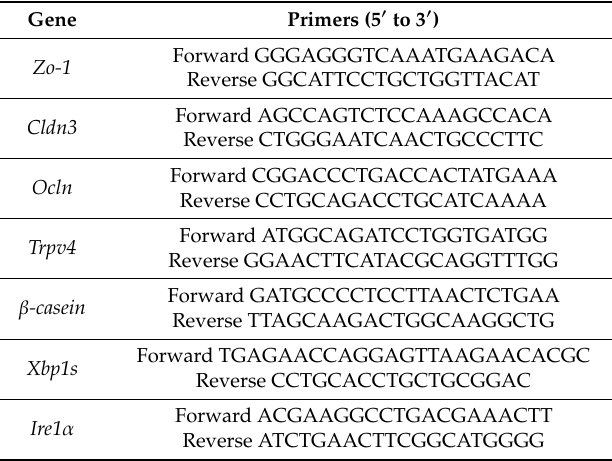
Table 1. Sequences of primers used for real-time PCR amplification.